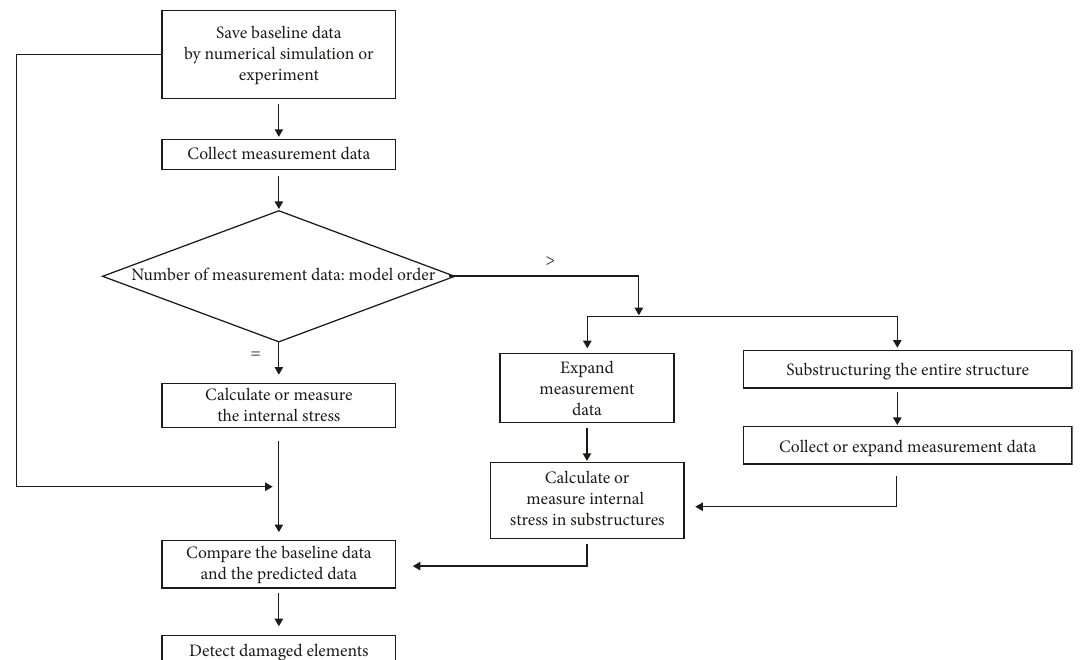
Figure 1: Flow chart of this work to detect damaged elements.